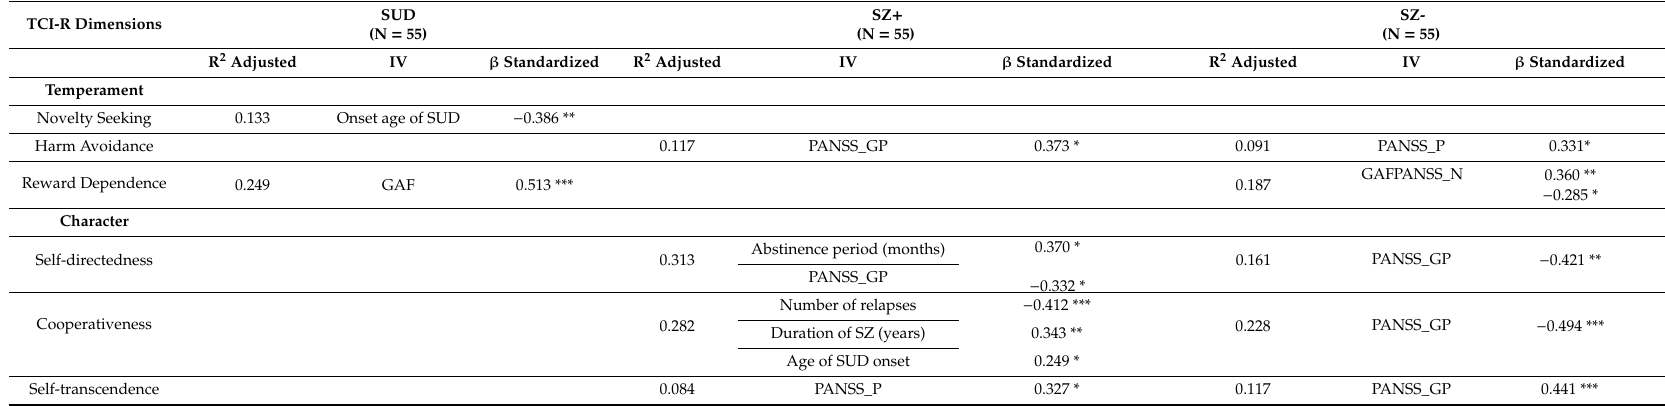
Table 4. Multiple linear regression models for the Temperament and Character Inventory-Revised (TCI-R) for the three